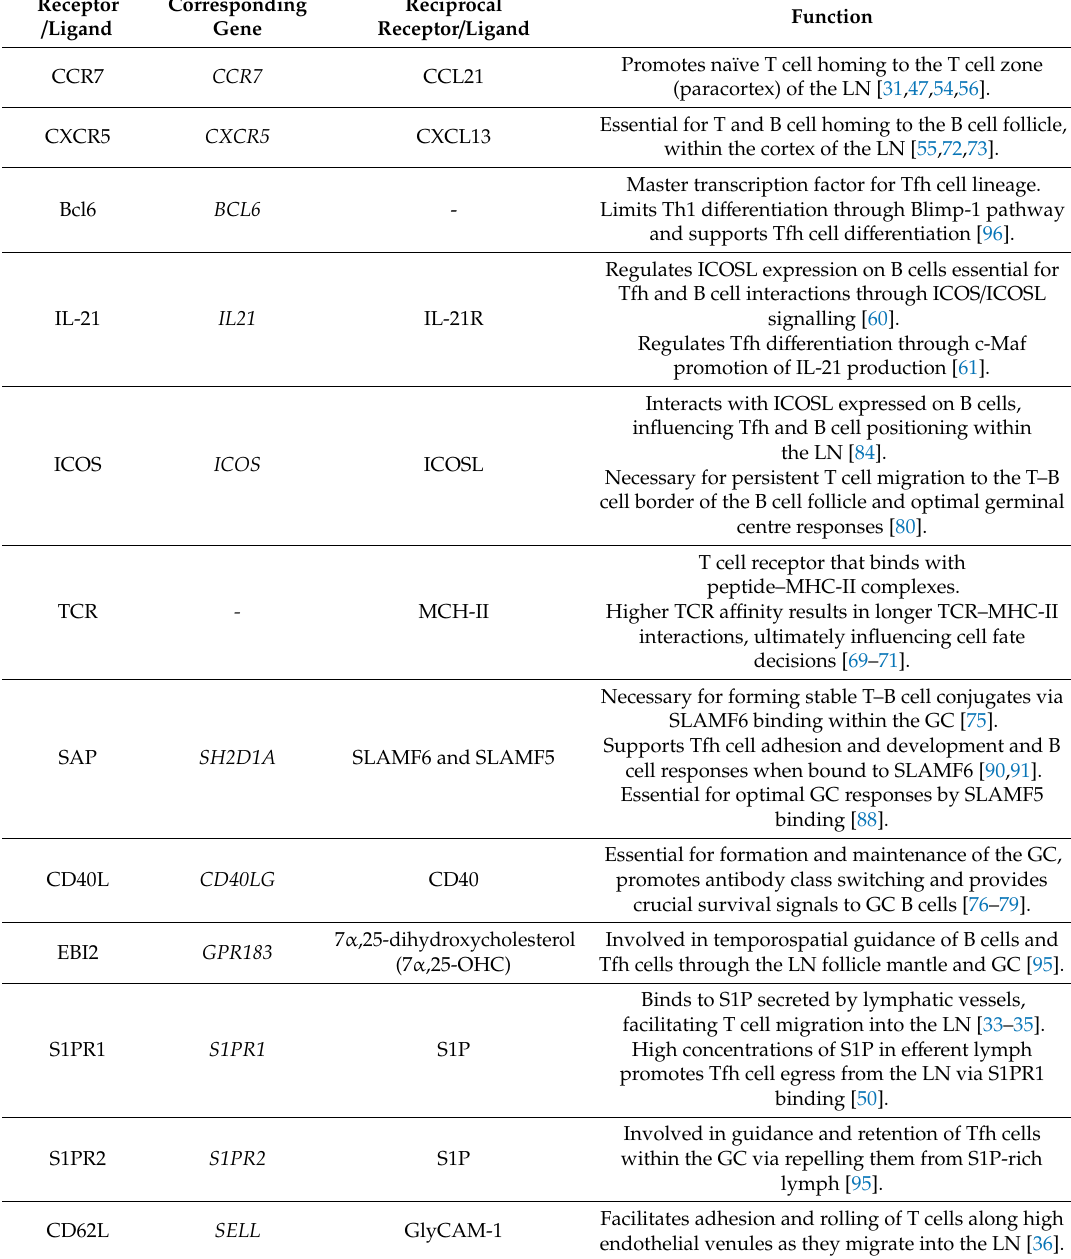
Table 1. Key Tfh cell receptors and